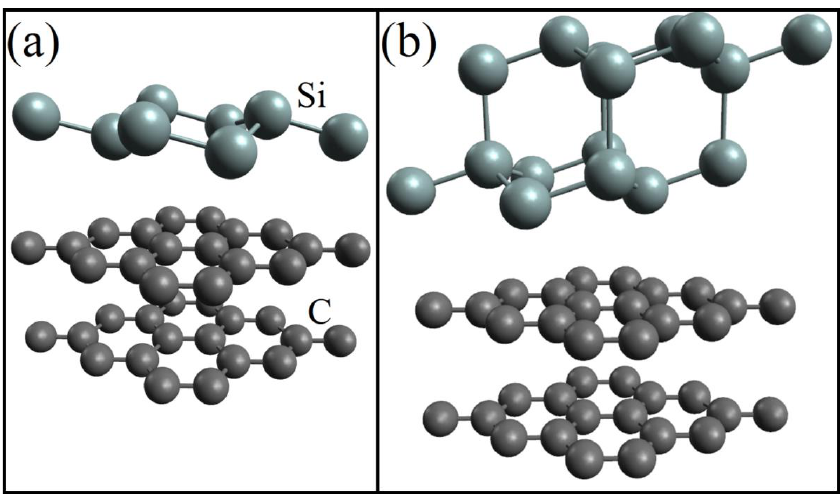
Figure 4. Geometric structure of ( a ) one- and ( b ) two-layer silicene on a graphite substrate after geometric optimization. Reprinted with permission from Ref. [46]. 2020, Springer.